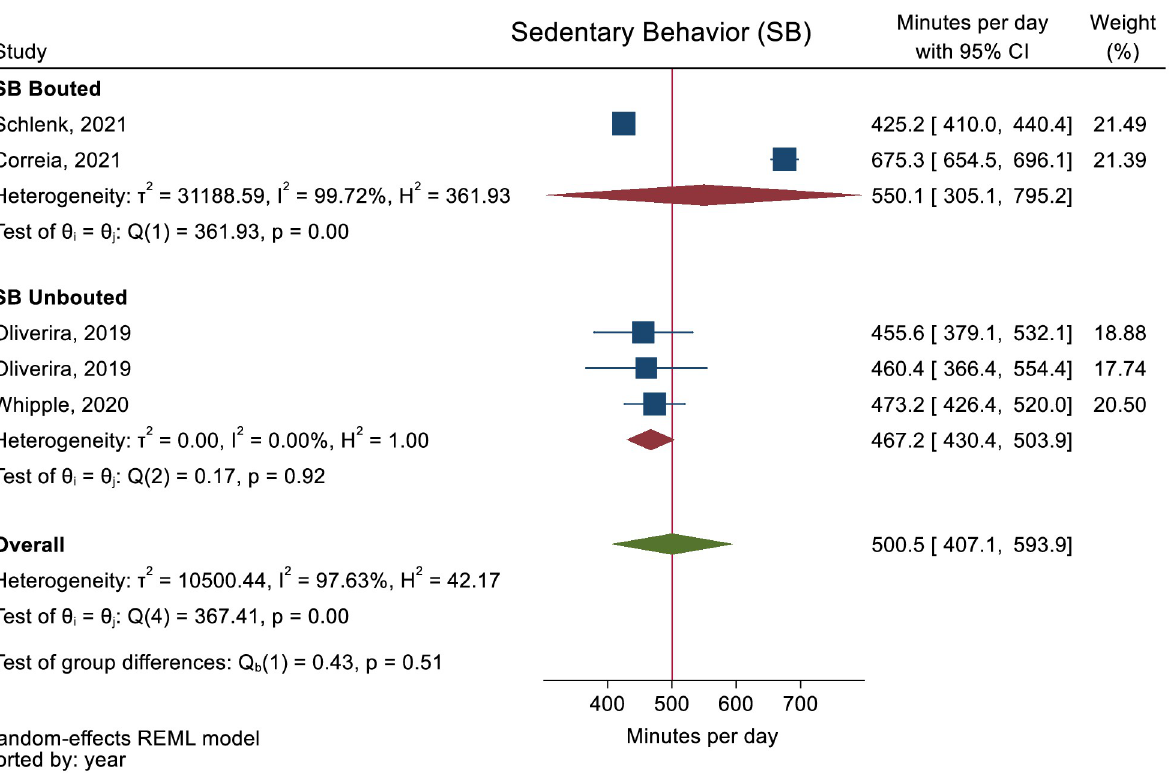
Fig 2. Forest plot showing daily minutes of Sedentary Behavior (SB) in people with multimorbidity.